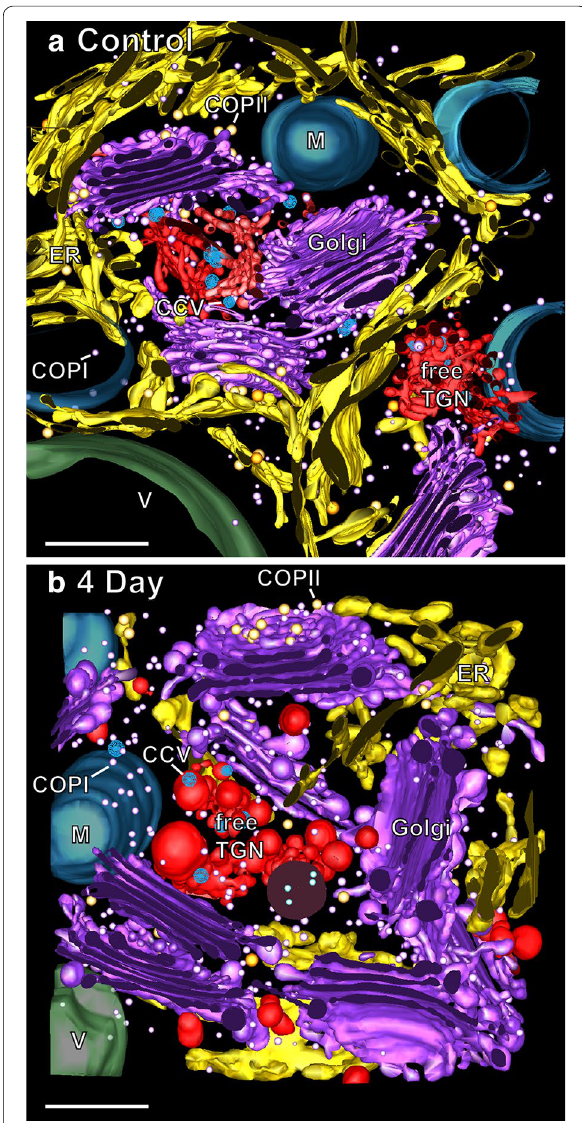
Fig. 6 Tomographic reconstructions of clustered Golgi stacks and associated ER cisternae in a control and a 4 day-induced Venus flytrap gland cell. a , b Tomographic models of clustered Golgi stacks in a control cell ( a ) and a 4 day-induced gland cell ( b ) derived from a serial tomograms (1 µm 2 µm 2 µm volumes). The purple × × Golgi stacks appear clustered with their cis -sides facing ER export sites in the encompassing ER membranes (yellow). The red colored free TGN cisternae are somewhat displaced from the trans -sides of the stacks. COPII-type vesicles (yellow), COPI-type vesicles (white), clathrin-coated vesicles (CCV, blue), mitochondrion (M, blue), vacuole (V, green). Bars 0.5